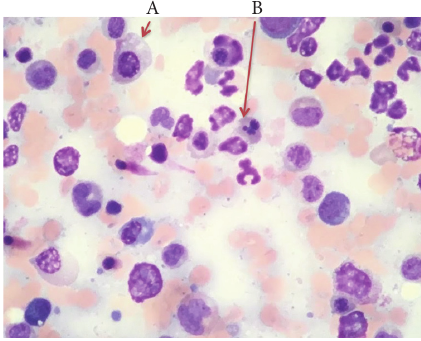
Figure 7: Bone marrow aspirate shows dyserythropoiesis including megaloblastic change (A) and nuclear budding (B).